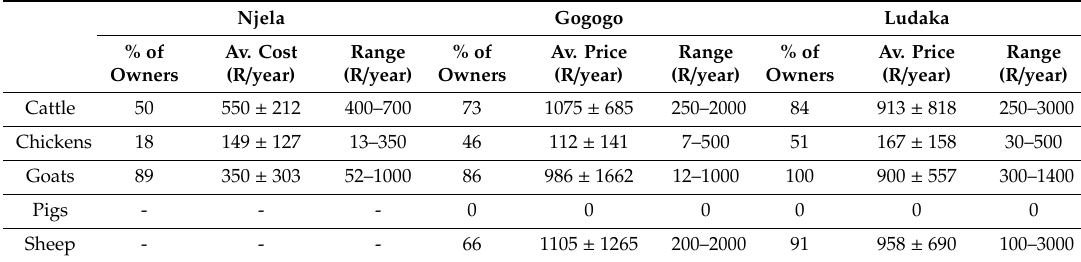
Table 8. Price (R / year) of the biomedical treatment or prevention for livestock and poultry-related